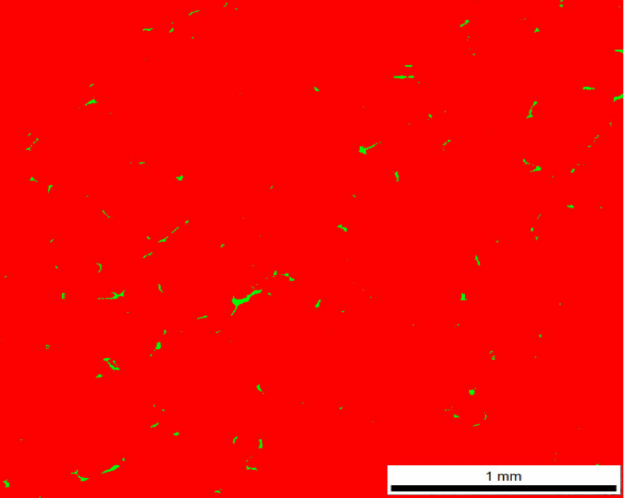
Figure 3. Phase map of original